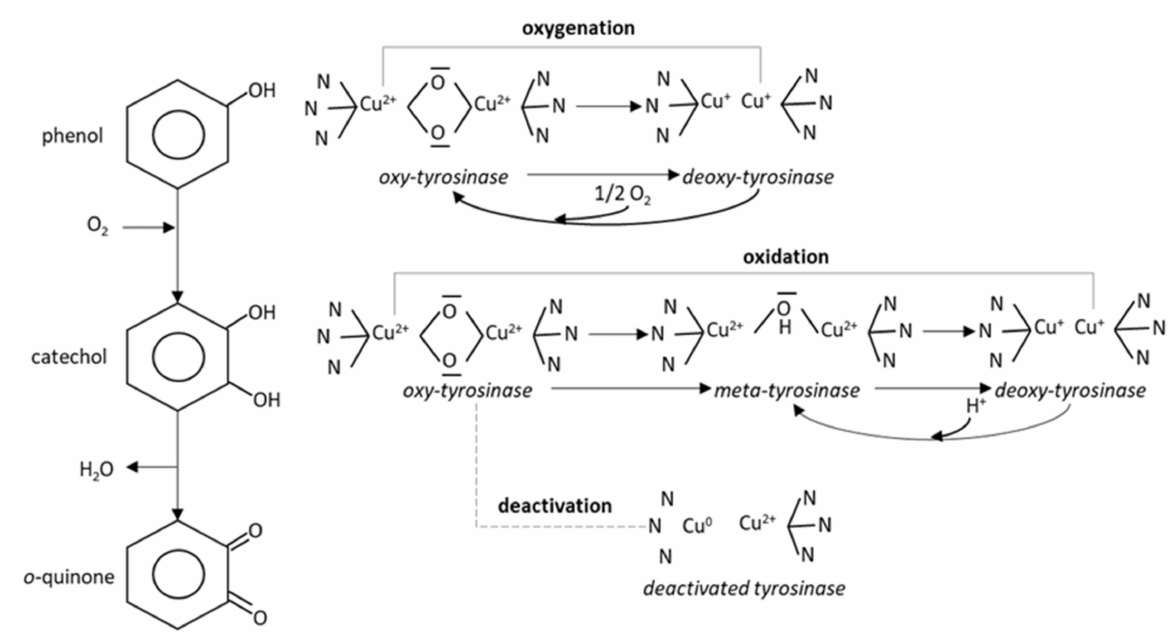
Figure 1. Tyrosinase catalyzed oxidation of phenol: phenol is hydroxylayted to catechol, which is dehydrogenated to o-quinone (left) or processed via the mono-oxygenase pathway (top right). Catechol follows the oxidase pathway (middle right); if it enters the mono-oxygenase pathway, the enzyme is deactivated (bottom